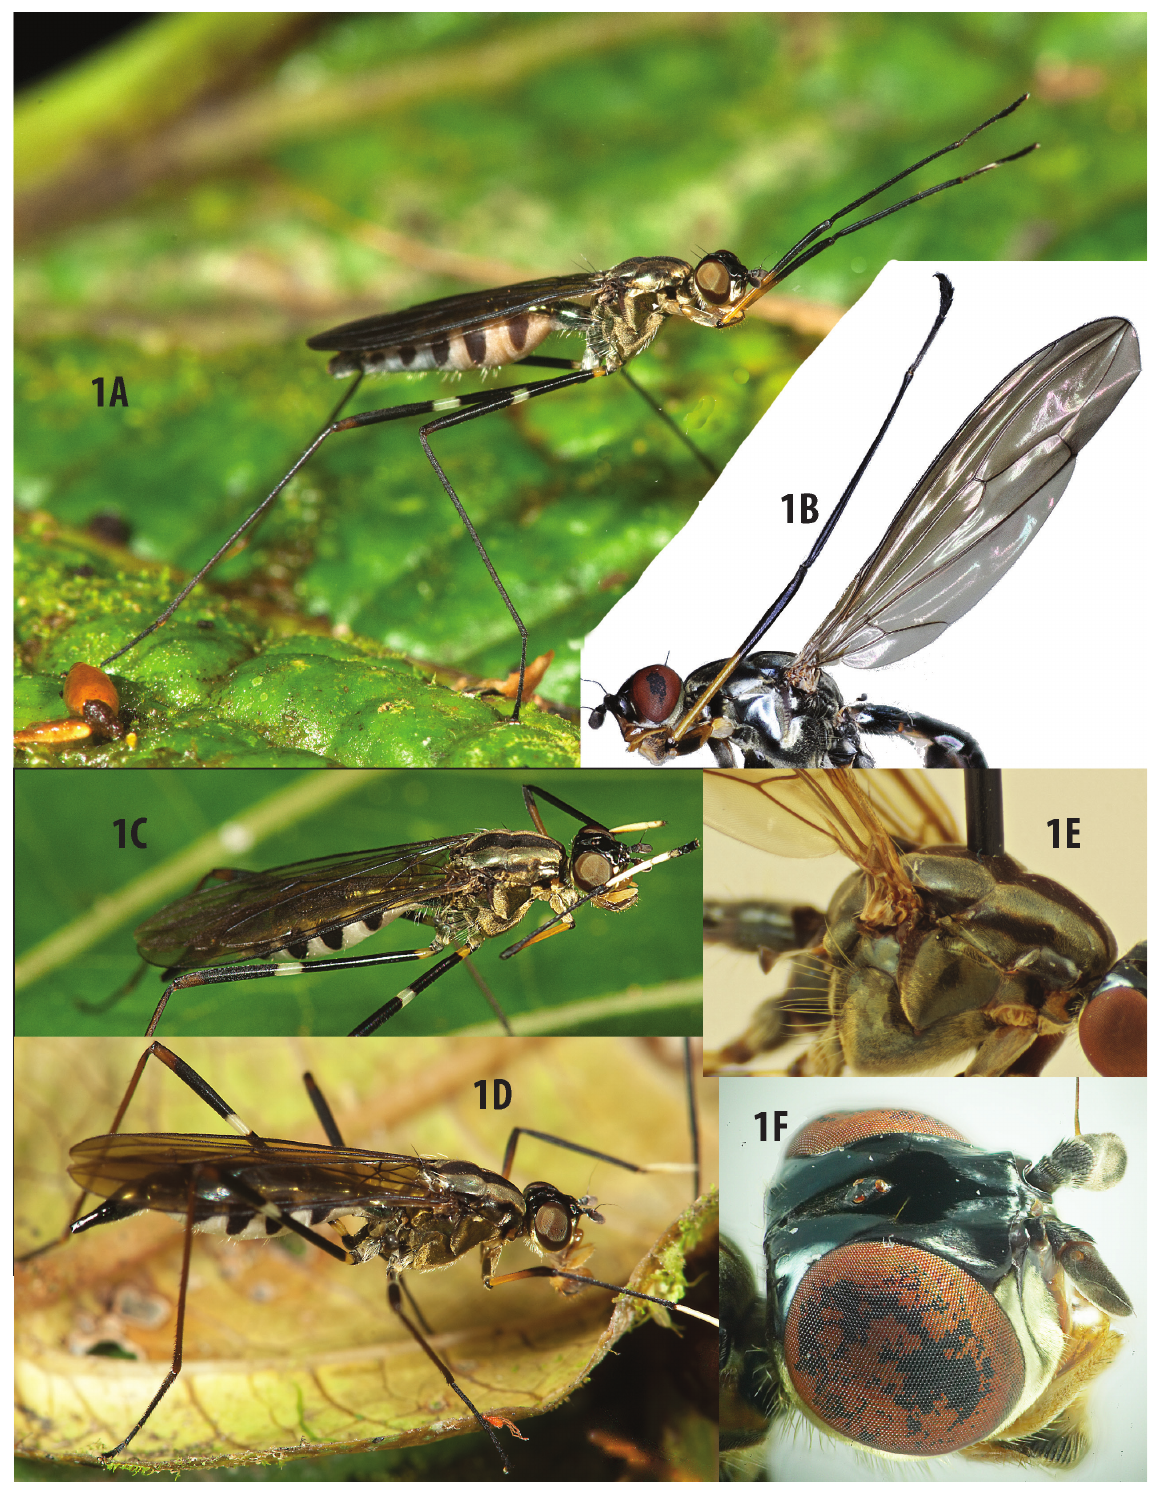
Fig. 1. Mesoconius albiseta sp. nov . , external characters. A . Holotype prior to capture, ♂, QCAZ. B . ♂, showing swollen fore tarsomeres. C–D . Paratype prior to capture, ♀, DEBU. E . Pleuron and base of abdomen to show katatergite. F . Head,